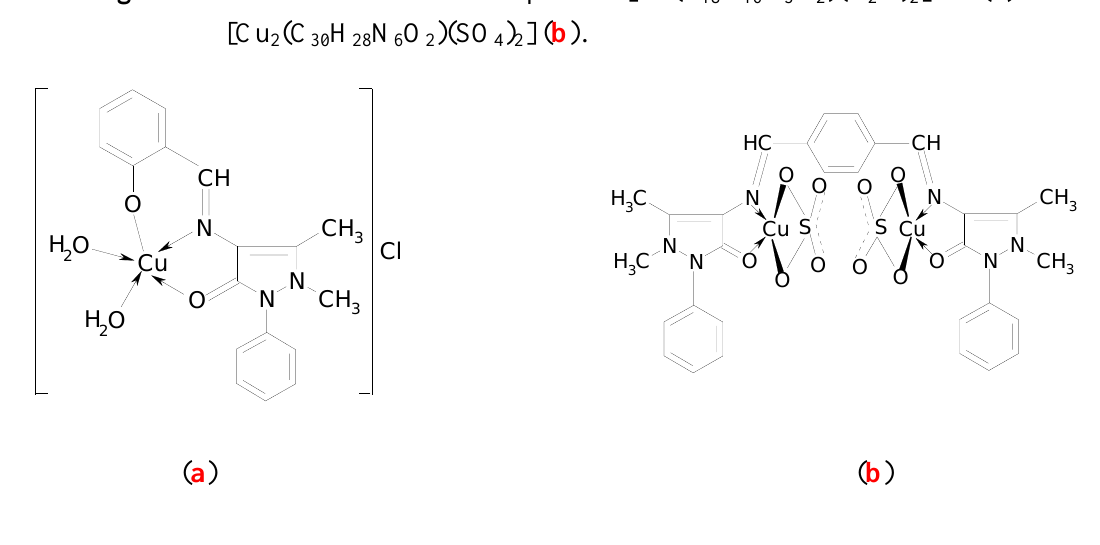
Figure 5. Structures of the complexes [Cu(C